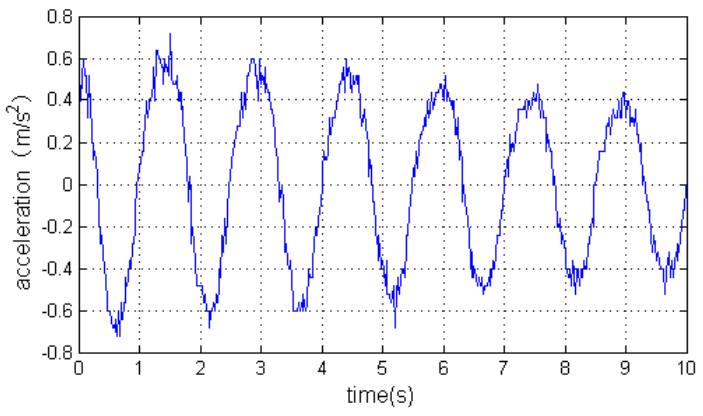
Figure 10. The angular rate.